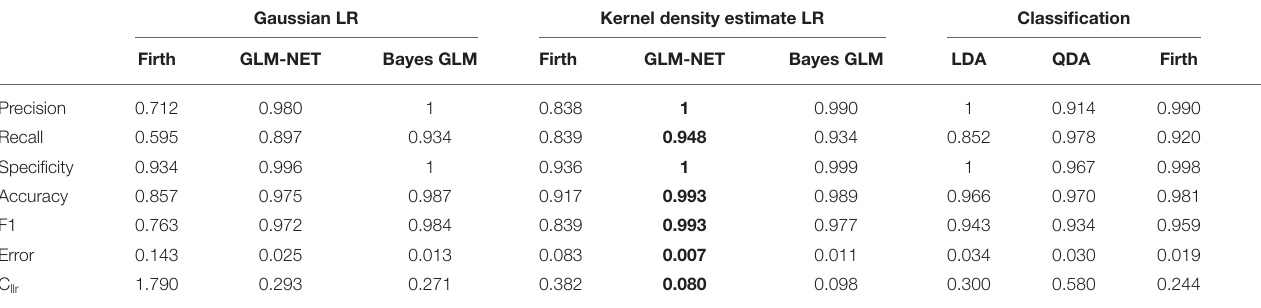
TABLE 5 | Classification performance measures for the alcohol biomarkers dataset using penalized Gaussian LR methods, penalized kernel density estimate LR methods and classification